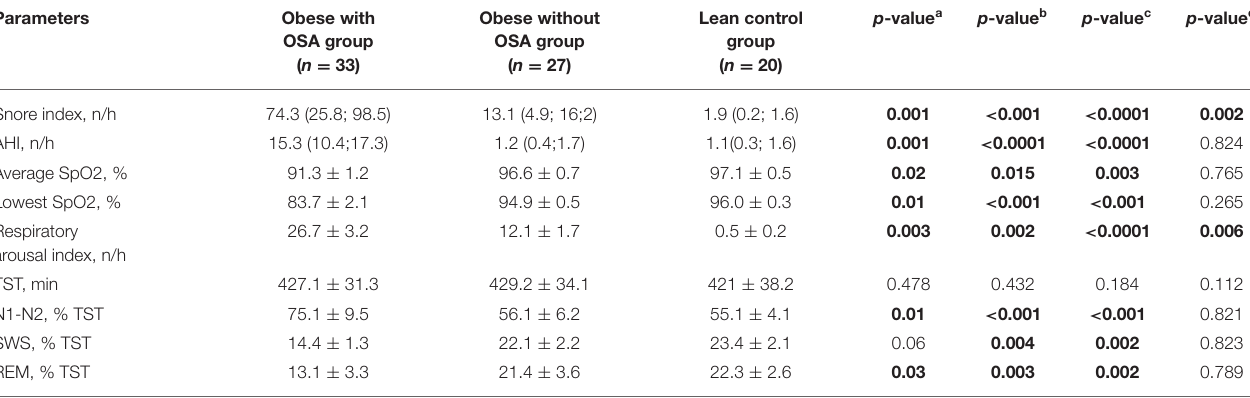
TABLE 2 | Polysomnographic data of the three groups of participants. Parameters Obese with OSA group